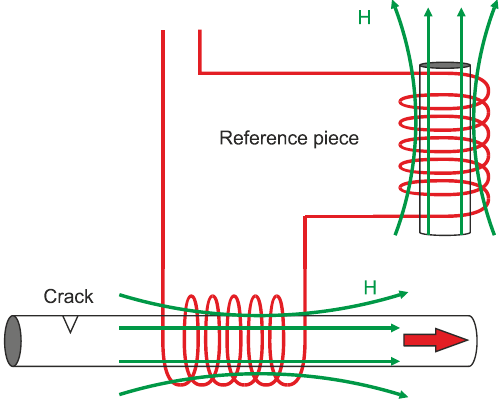
Figure 22. Compensated absolute encircling coil